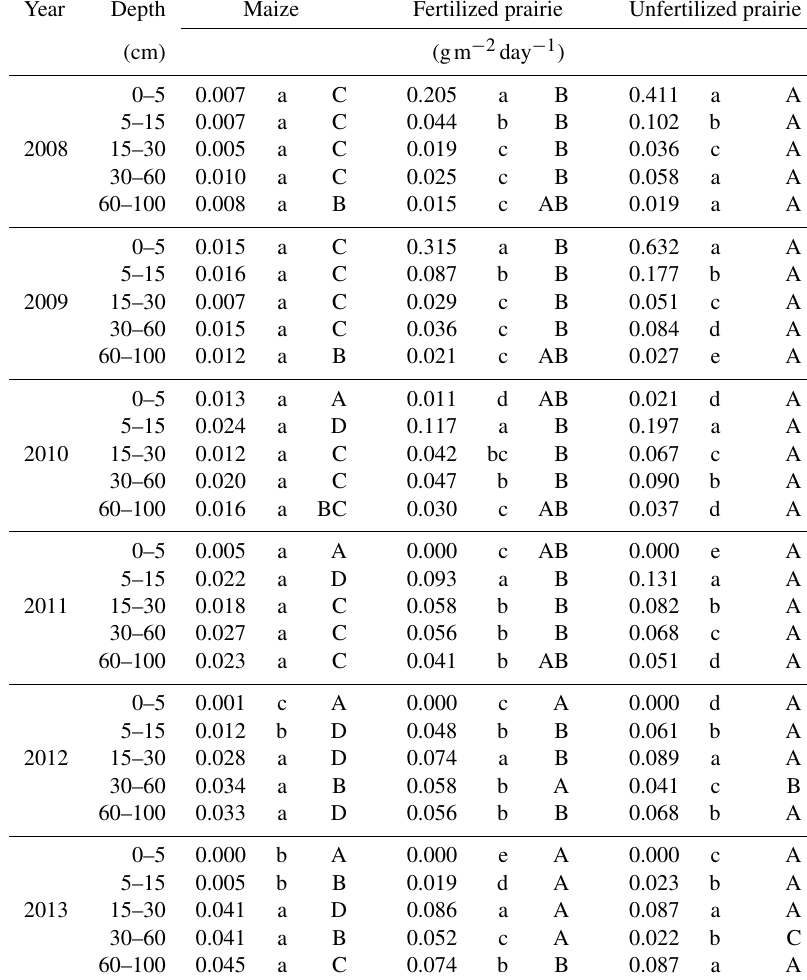
Table A1. Root pool accumulation rates averaged across each growing season (gm − 2 day − 1 ). Differences in lowercase letters indicate significant differences between depths within treatments within years (up and down). Differences in uppercase letters indicate differences between treatments within depths within years (left to